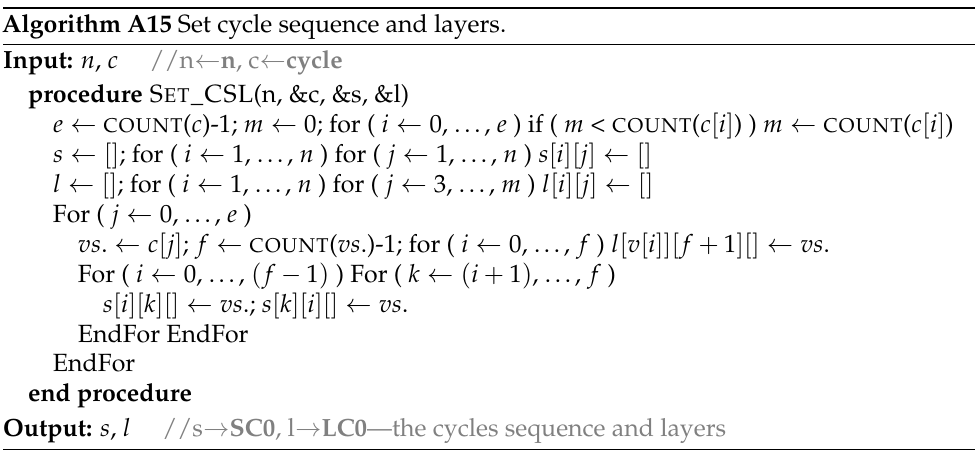
Algorithm A16 Count and sum for paths and cycles.